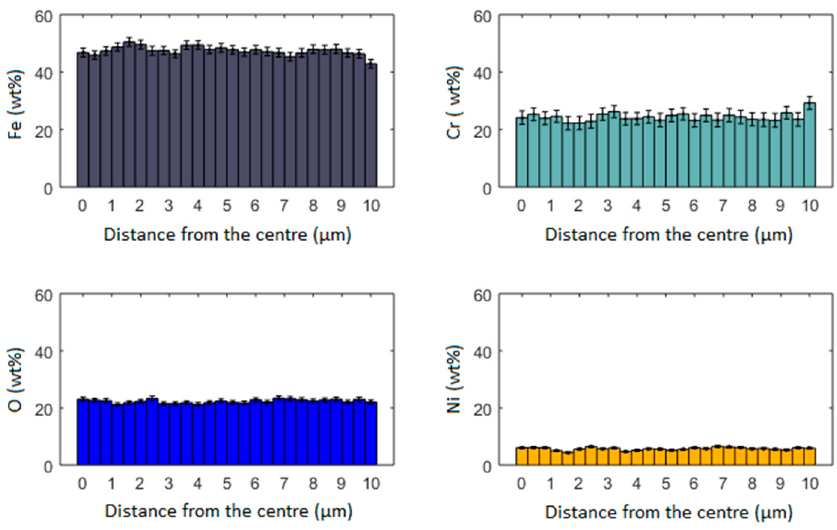
Figure 8. The spatial distribution of chemical elements inside the particle.